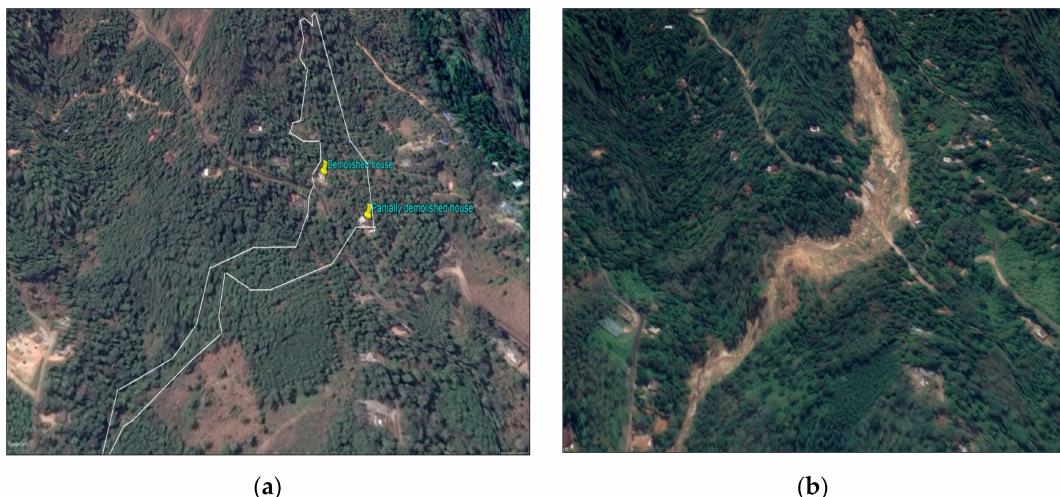
Figure 2. Photos of the affected site ( a ) before and ( b ) after the landslide (From Google